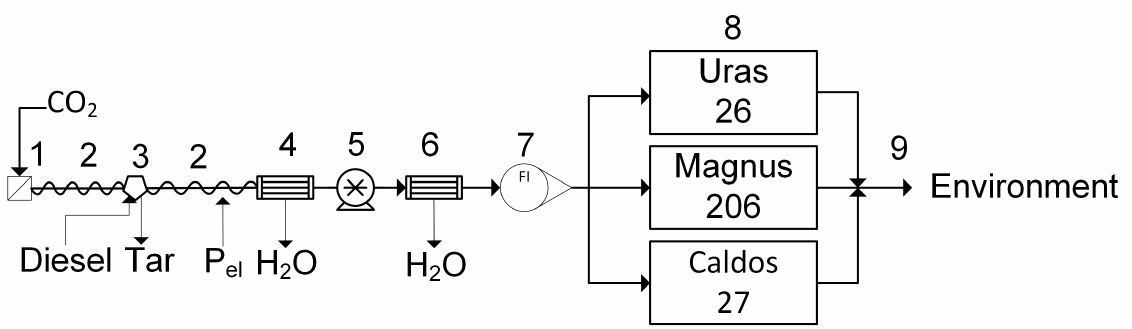
Figure 6. Schematic of the gas analysis equipment: (1) heated probe with filter, (2) heated tube, (3) tar removal (only for FR), (4) condenser for water removal, (5) pump, (6) condeser for water removal, (7) rotameter, (8) measurement equipment, (9) safe location in the